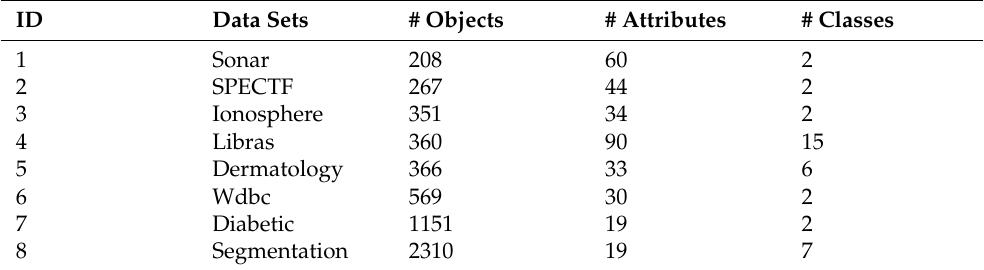
Table 3. The description of data